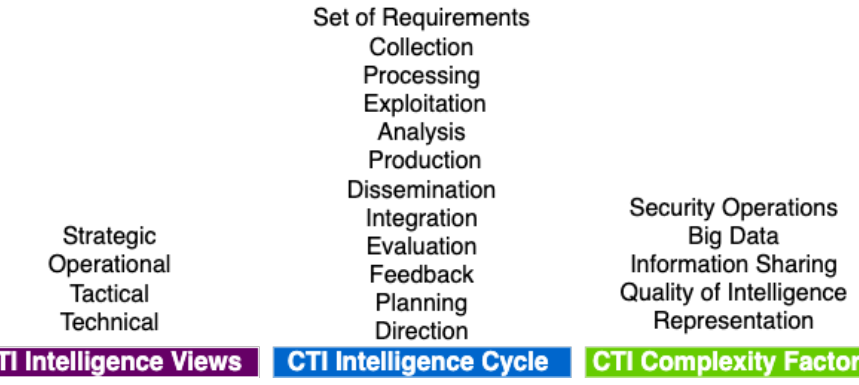
Figure 4. Identified Model Elements arranged in three CTI Concepts